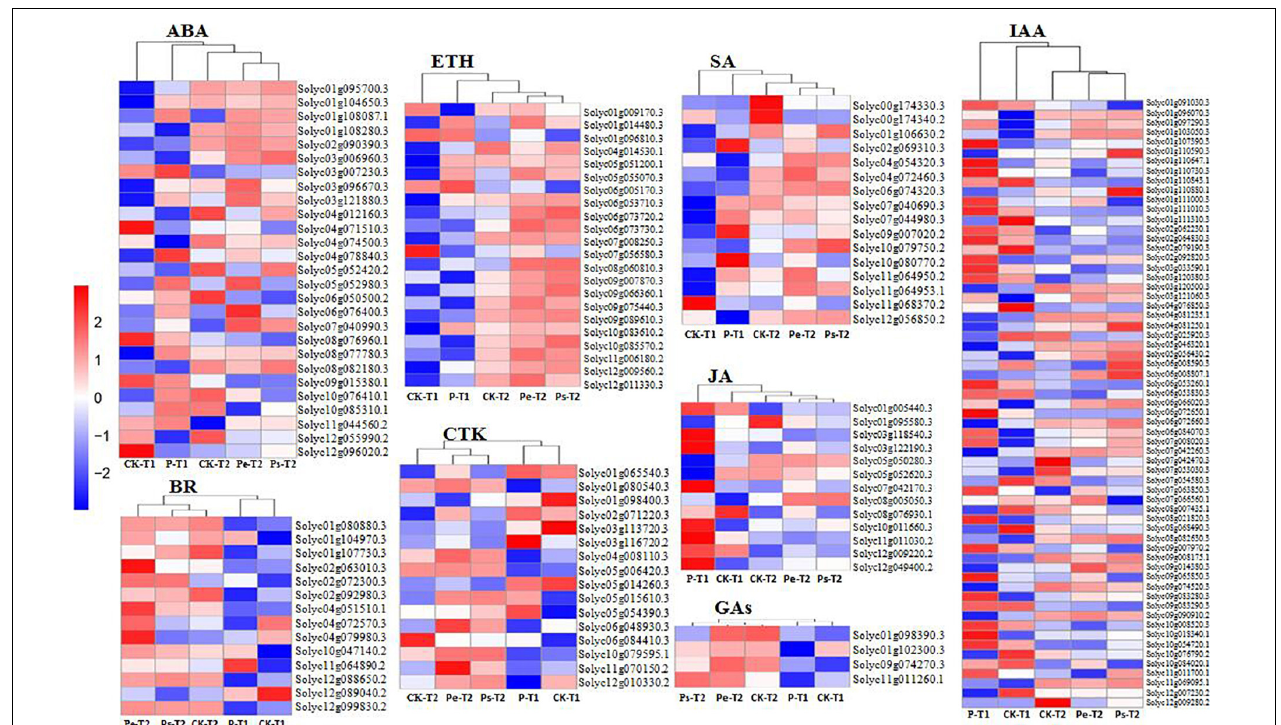
FIGURE 7 | The heatmaps about hormones biological functions DEGs enriched by KEGG analysis. The FPKMs were homogenized by Z-score, which was a log based on multiple and folded changes with pairwise comparisons. The red and the blue colors indicate high and low transcript